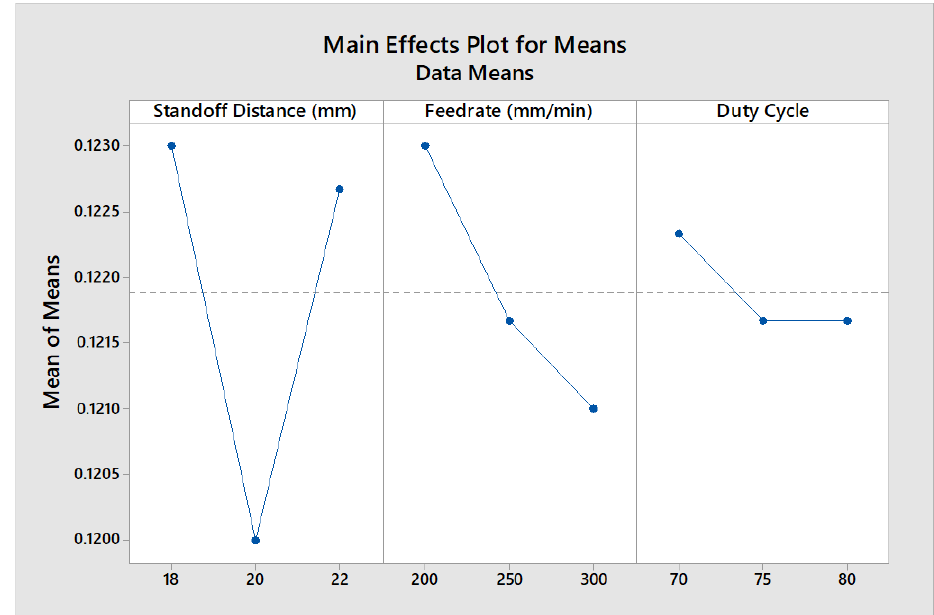
Figure 8. MEP of process factors on KW.